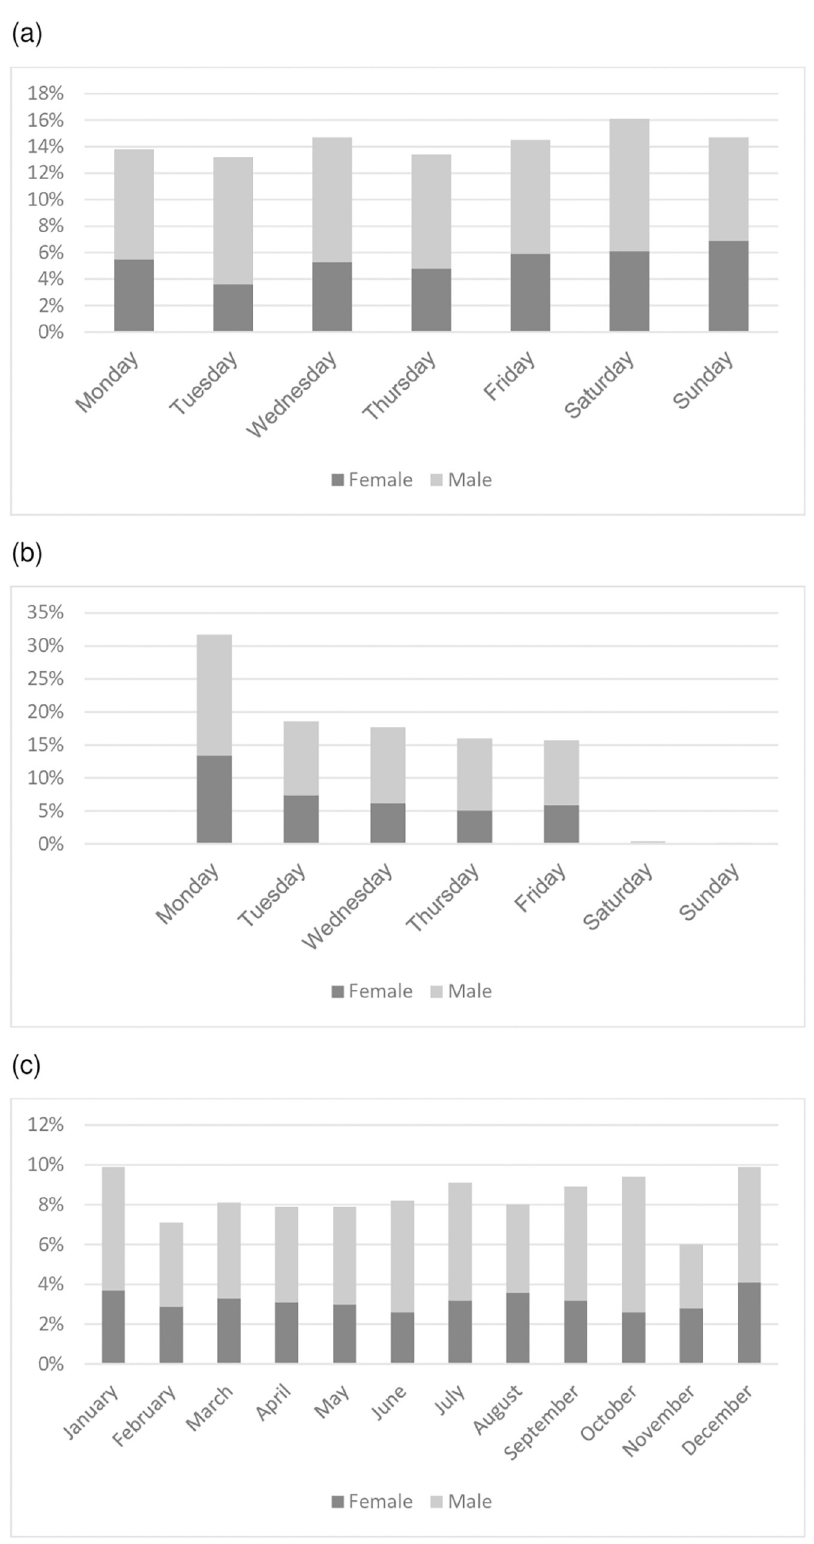
Fig 5. Bar chart presenting